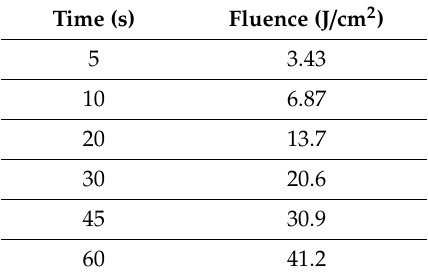
Table 1. Doses of blue light used to perform the experiments.